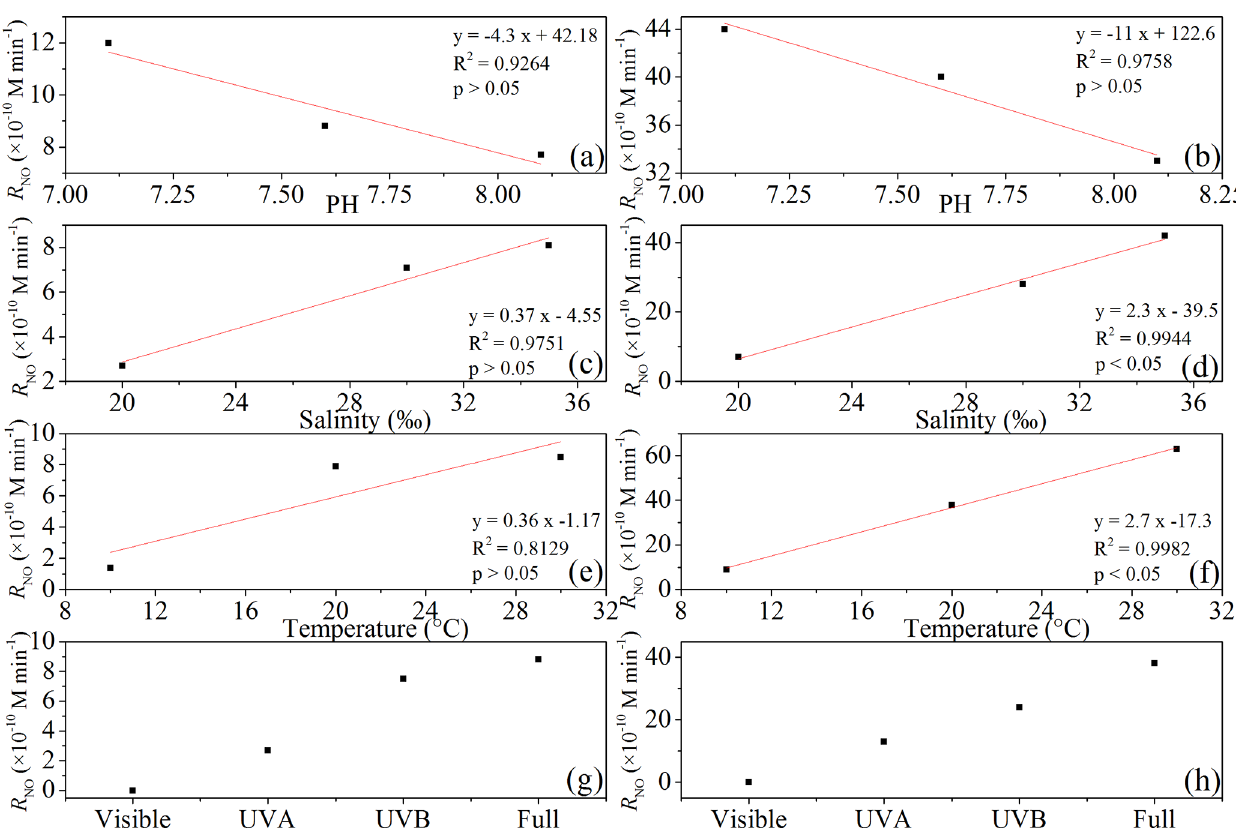
Figure 5. Changes in NO photoproduction rates with irradiation time at different pH, salinity, temperature, and illumination conditions ( a , c , e , and g for 0.5µmolL − 1 NO − and b , d , f , and h for 5.0 µmolL − 1 NO − ). 2 2 (4.0–7.0 mmol L − 1 ) in solution had no effect on the